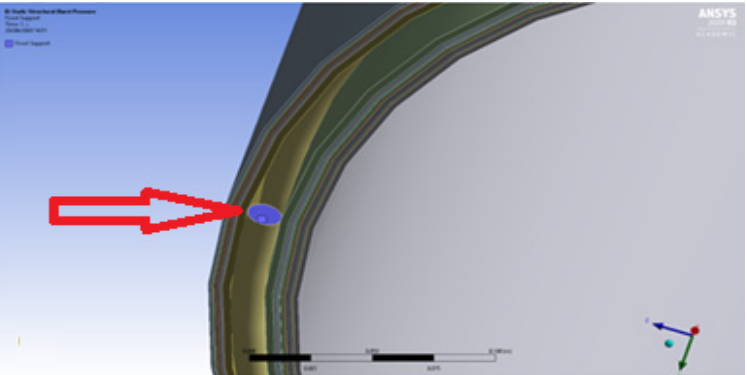
Figure 8. Fixed boundary condition showing end of helical spring of the marine hose in ANSYS Static Structural 2019 R3. (The arrow points to the location of the fixation, not the load application.)